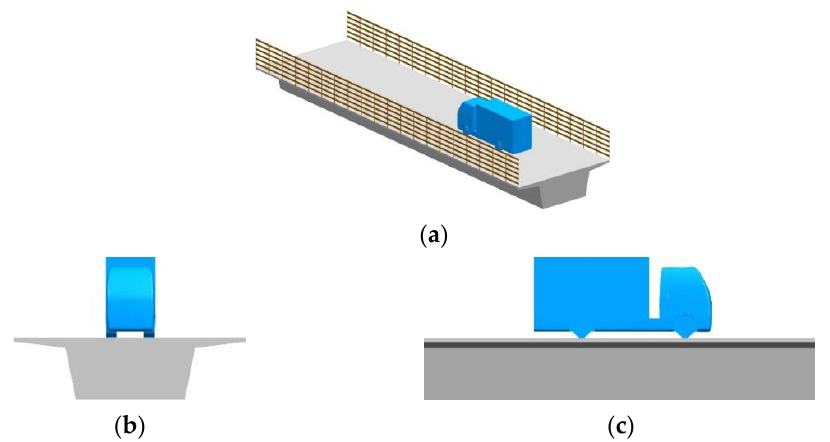
Figure 1. Geometric model of the truck on the bridge (( a ) Axonometric view of bridge; ( b ) front view of the bridge; ( c ) side view of the bridge).